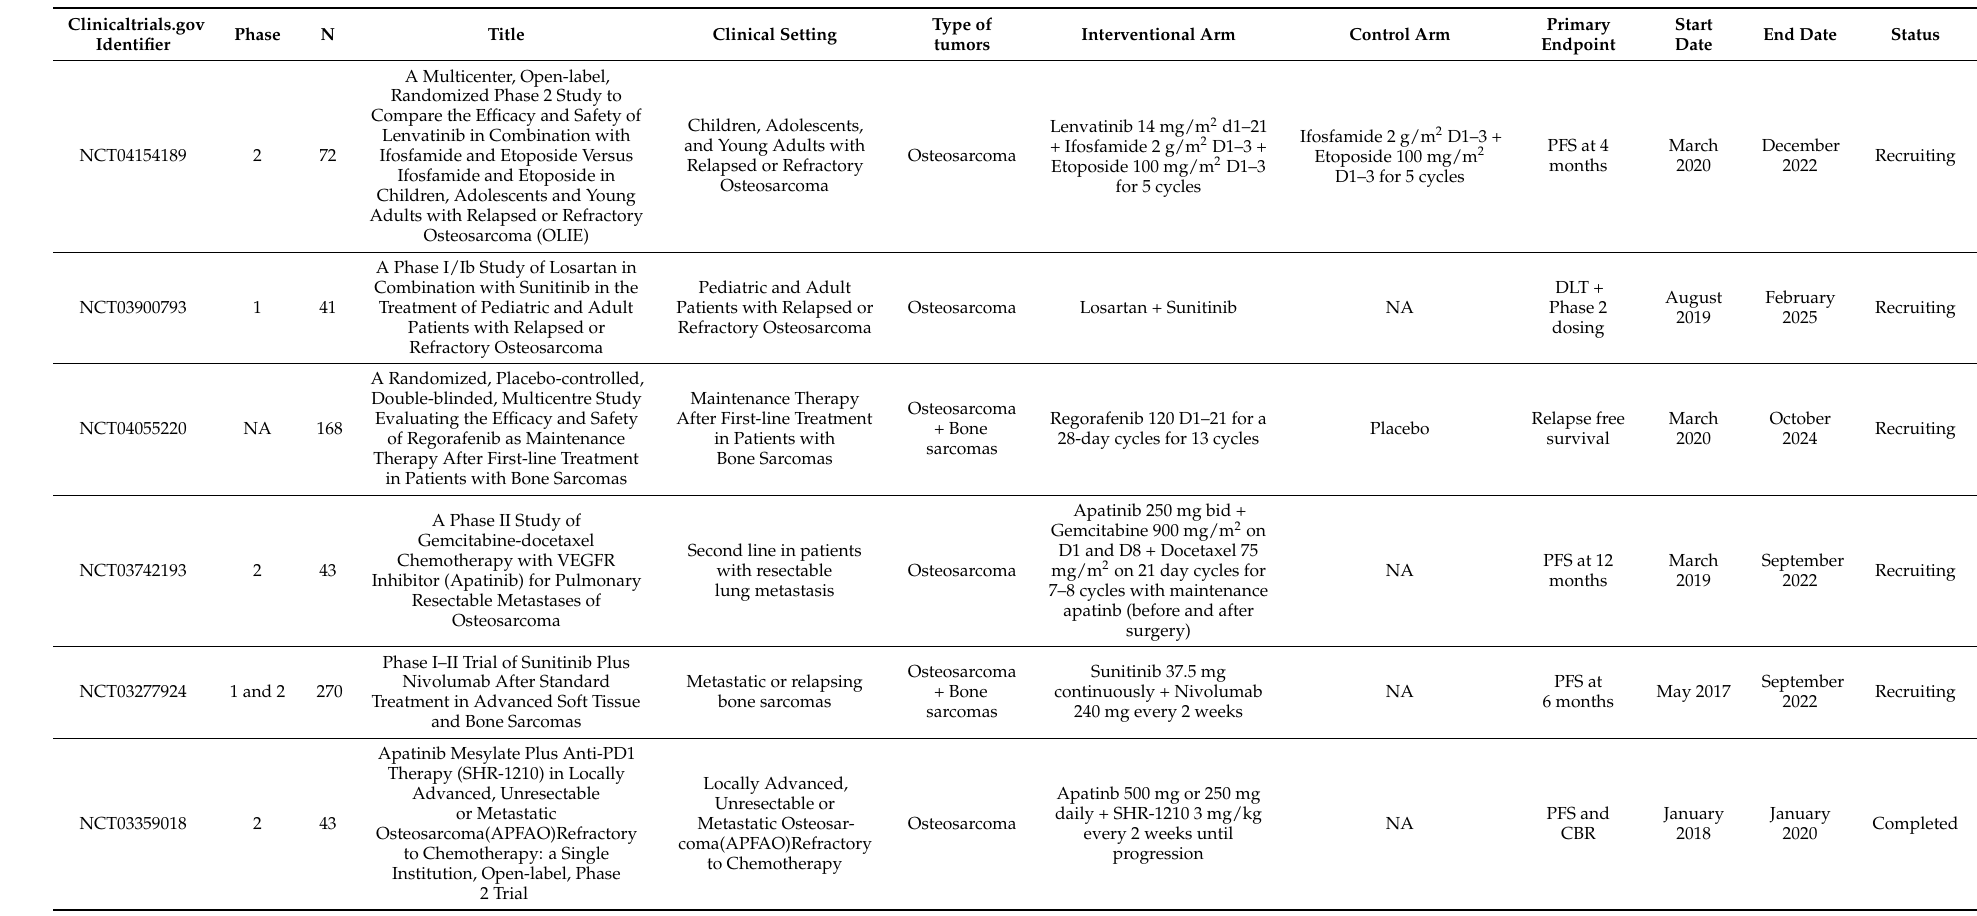
Table 2. Ongoing clinical trials of anti-VEGF agents in